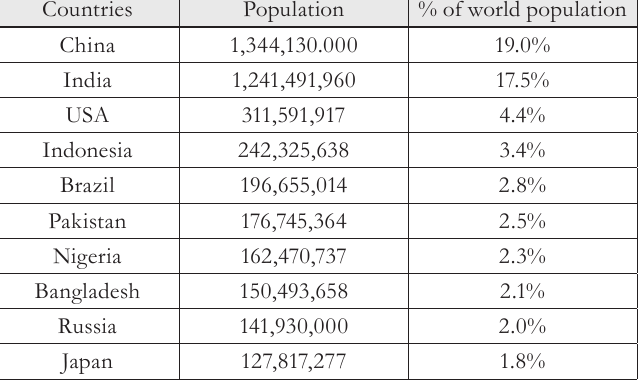
Tab. 1 - Top ten countries with largest total population in 2011. Source: World Bank (www.data- worldbank/indicator/SP.POP.TOTAL/countries).